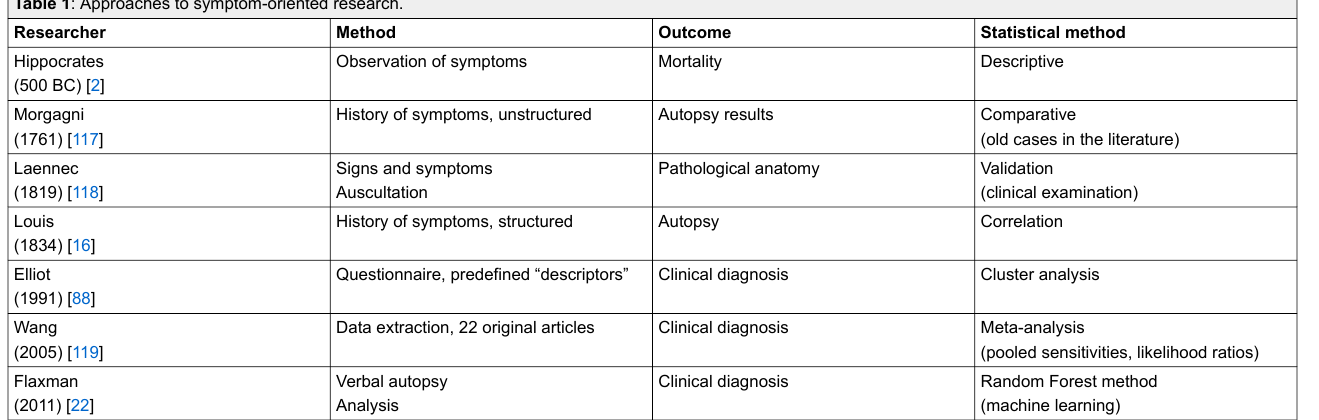
Table 1 : Approaches to symptom-oriented research.